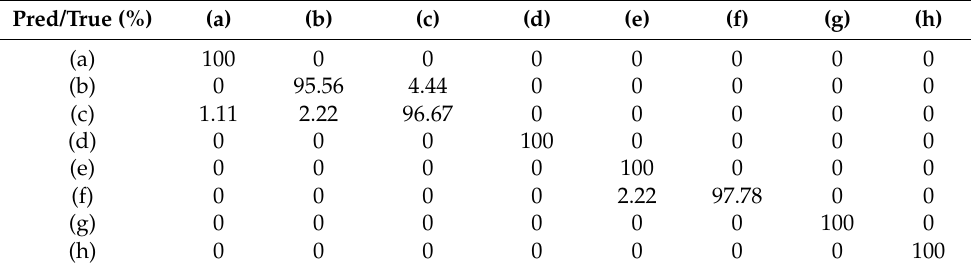
Table 2. The confusion matrix of action recognition.